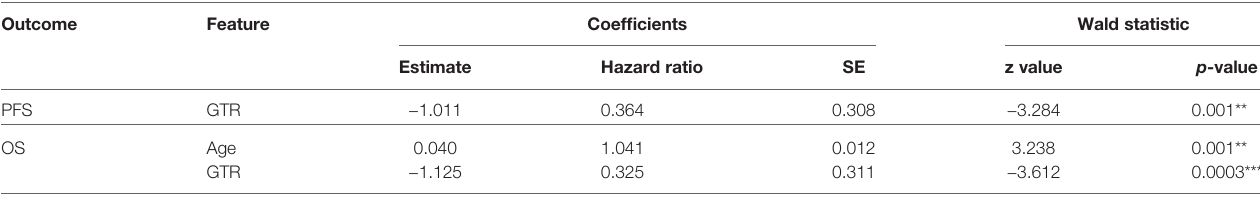
TABLE 5 | Cox proportional hazards regression models best describing survival outcomes.